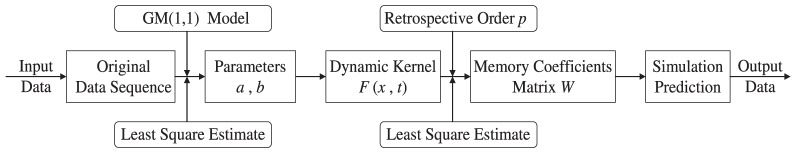
Programming procedure for the SMGM(1,1) model.